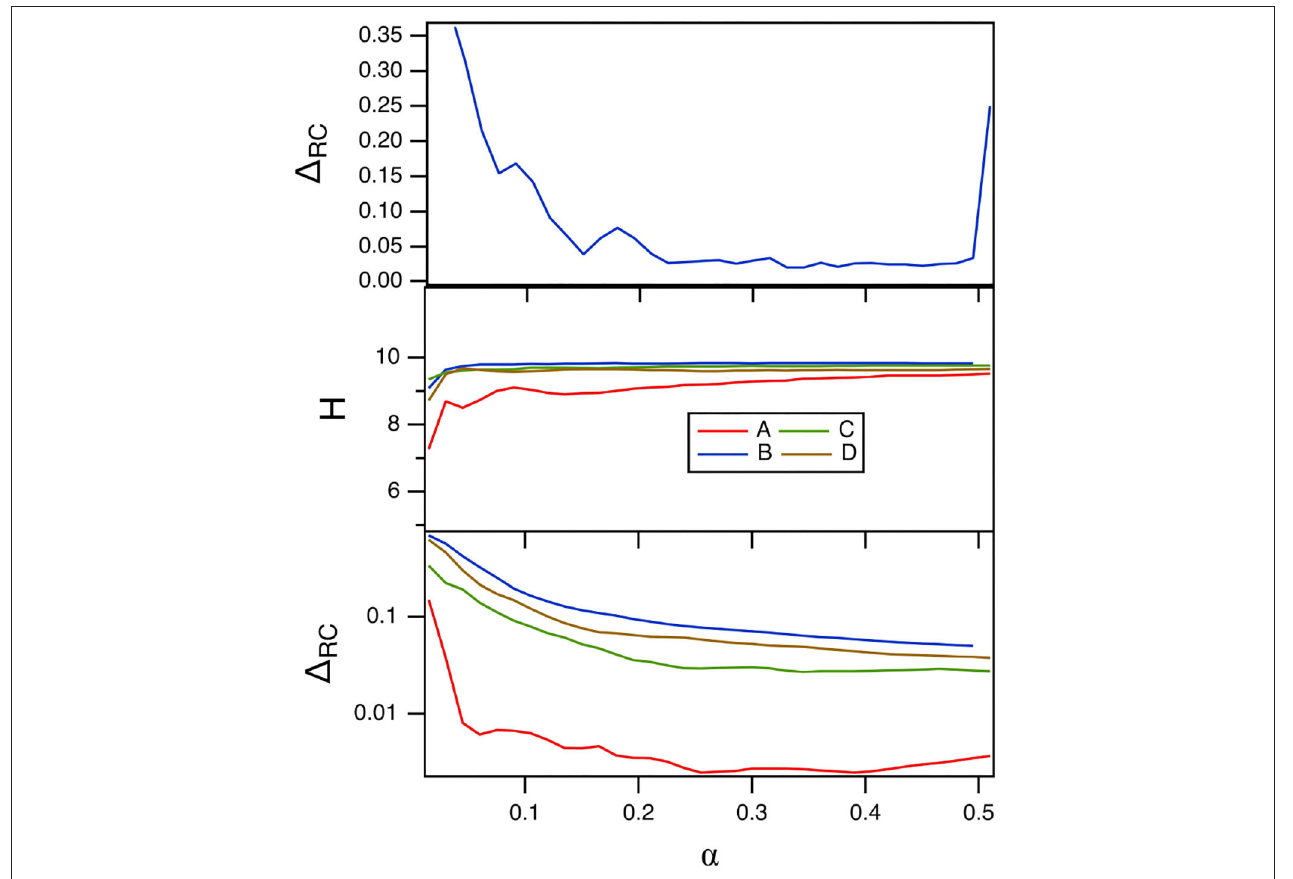
FIGURE 9 | The top plot shows the fraction of errors E C in identifying which of the four Sprott systems was present, as a function of the time scale parameter α for the polynomial ODE reservoir computer. The middle plot shows the entropies for the four Sprott systems over the same parameter range, while the bottom plot is the training error 1 RC . For this plot, p 1 = − 0.5 and the spectral radius σ =